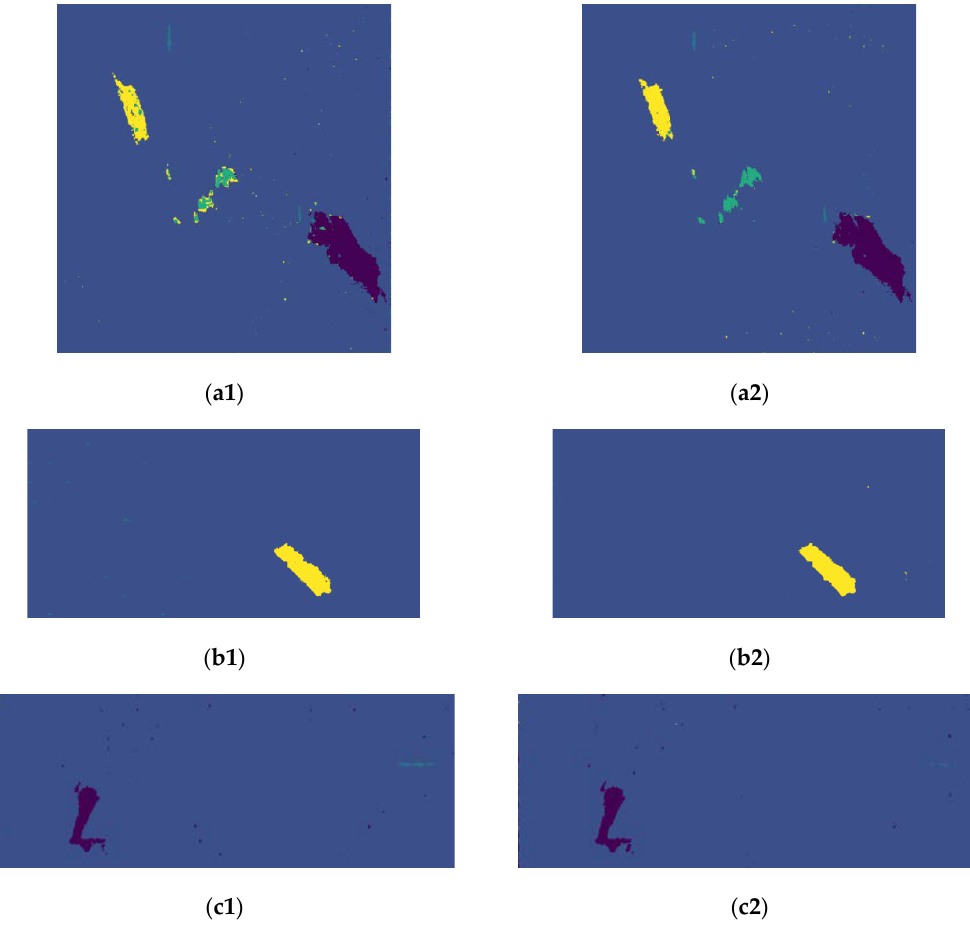
Figure 12. The whole classification result of Yamaguchi 4-component parameters. Left: the results without SLIC superpixel; right: the results with SLIC superpixel. ( a1 , a2 ) Image 1, ( b1 , b2 ) Image 2, ( c1 , c2 ) Image 3.